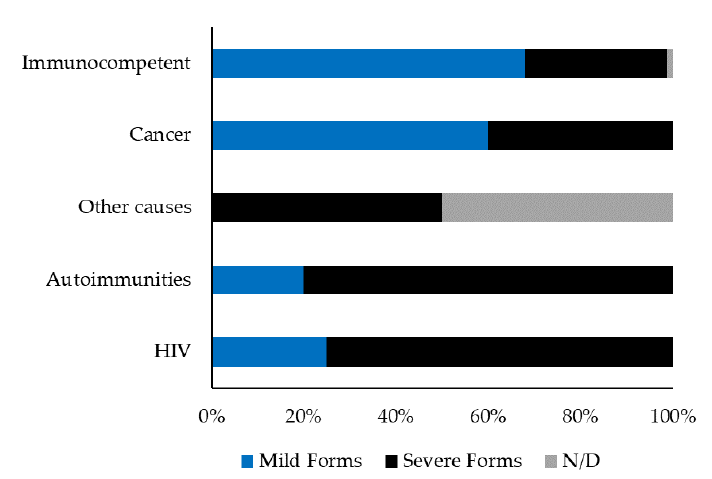
Figure 5. Comparative features of tegumentary leishmaniasis by patients’ immune status (n = 102). Severe and mild TL were defined in the Material and Method section. ND; not defined.